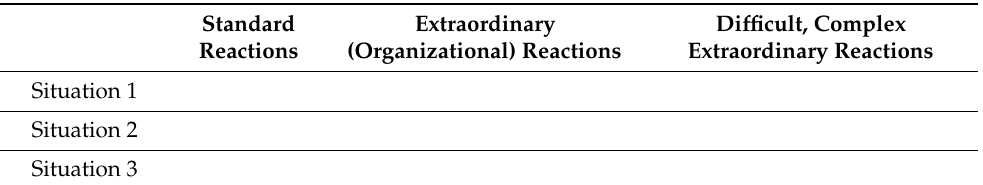
Table 1. Differentiation of the situations analyzed by the respondents vs. extraordinary personnel reactions: layout in the research